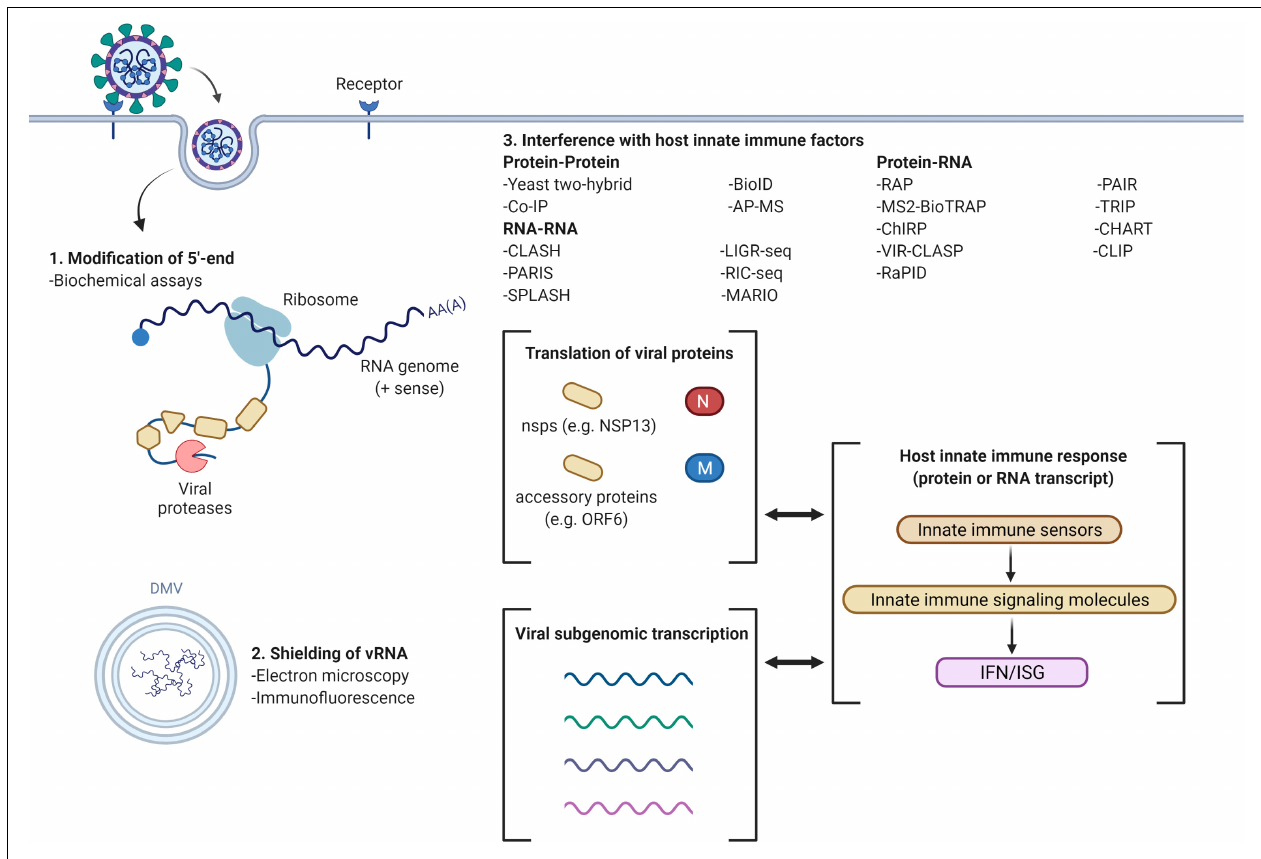
FIGURE 1 | Viral evasion mechanisms and methods for investigation (example with SARS-CoV-2). Common methods of innate immune evasion by viruses include the modification of 5 (cid:48) -end, double membrane vesicles (DMV) to shield viral RNA (vRNA) and interference with host innate immune factors. 5 (cid:48) -end modifications may be determined using biochemical assays; formation of DMV can be detected by electron microscopy and immunofluorescence localization. The host innate immune response may be interrupted through protein-protein interactions, RNA-RNA interactions and viral (protein)-host (RNA)/viral (RNA)-host (protein) interactions, attenuating interferon (IFN) and interferon stimulated gene (ISG) expression. Figure created using